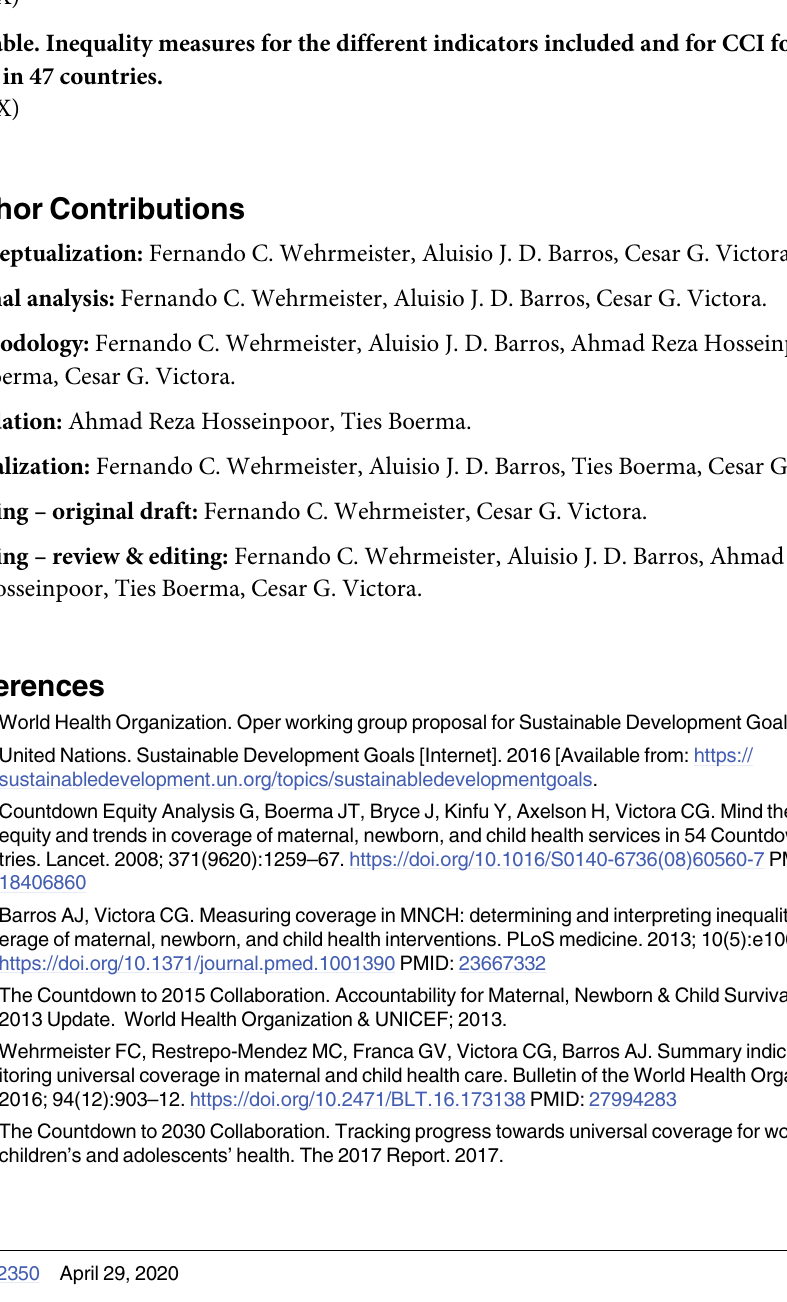
S1 Table. Surveys included and the coverage, slope index of inequality and concentration index for each of the different composite coverage index formulations. S2 Table. Inequality measures for the different indicators included and for CCI formula- tions in 47